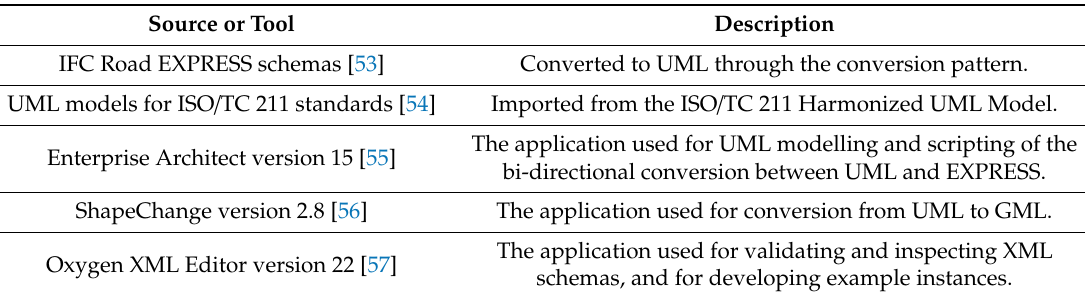
Table 2. Data sources and